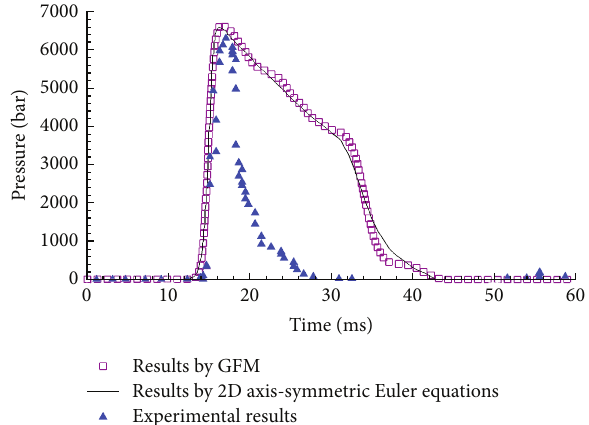
Figure 13: Comparisons among the results presented, the results by 2D axis-symmetric equations and experimental results (Case 5).